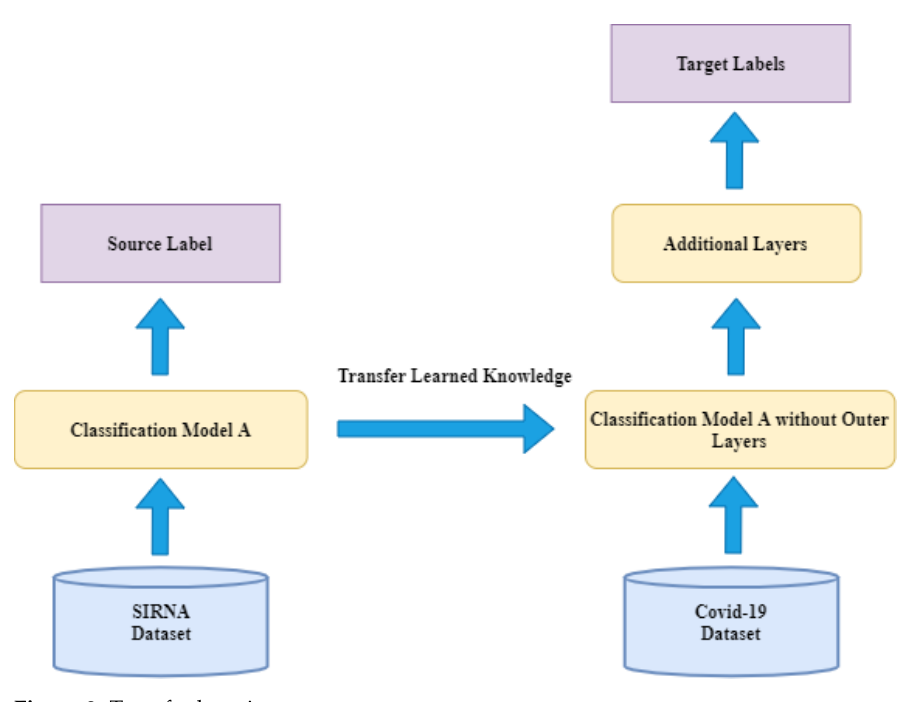
Figure 2. Transfer learning concept.